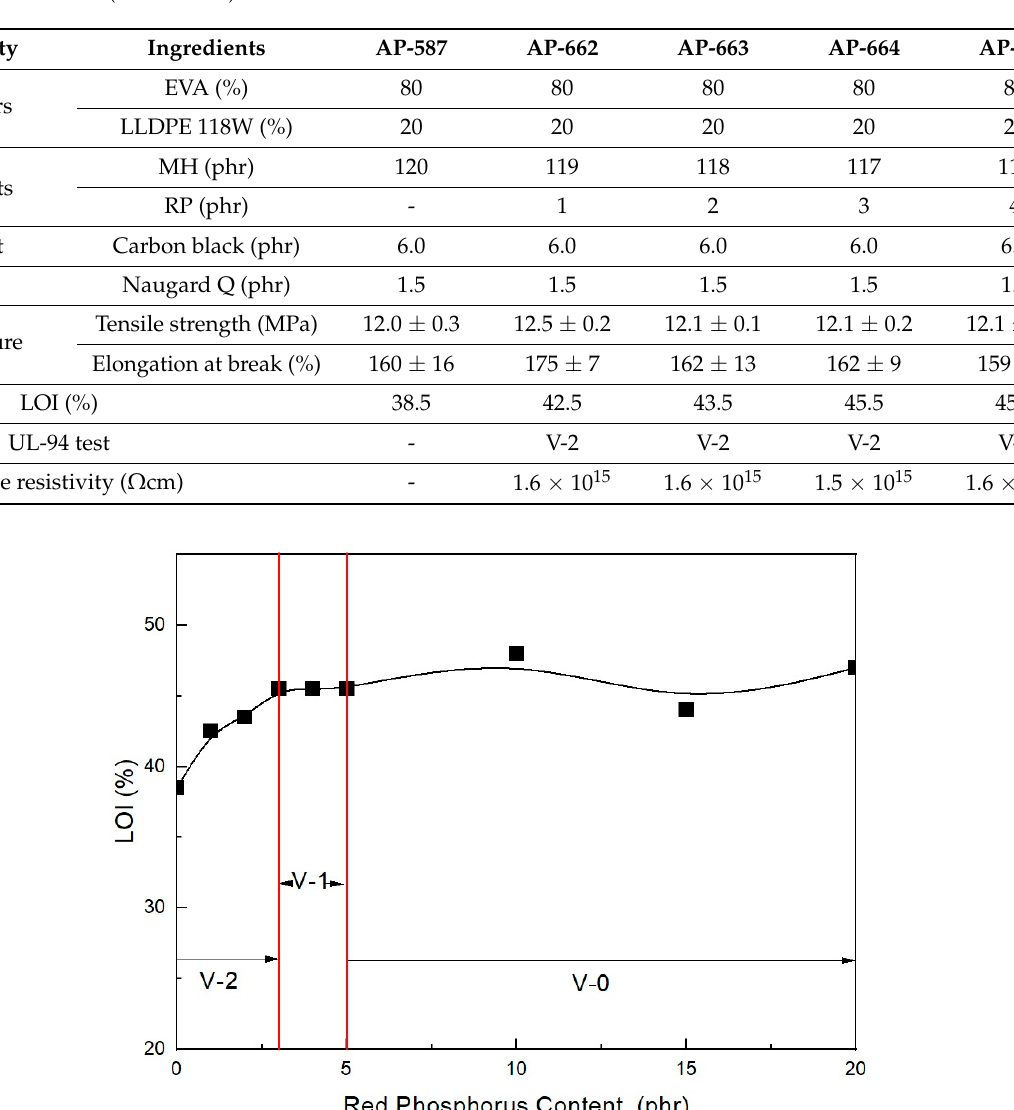
Table 1. EVA/LLDPE 118W/120 phr flame-retardant (MH + RP) formulations as a function of RP